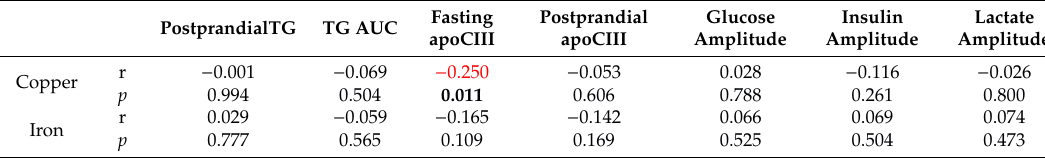
Table 7. Partial correlation between changes from week 0 to week 2 in metal and metabolism markers adjusted for fructose, glucose, BMI, and sex. p < 0.05 are shown in bold with r < 0 shown in red. TG AUC, triglyceride area under the curve; apoCIII, apolipoprotein CIII. TG